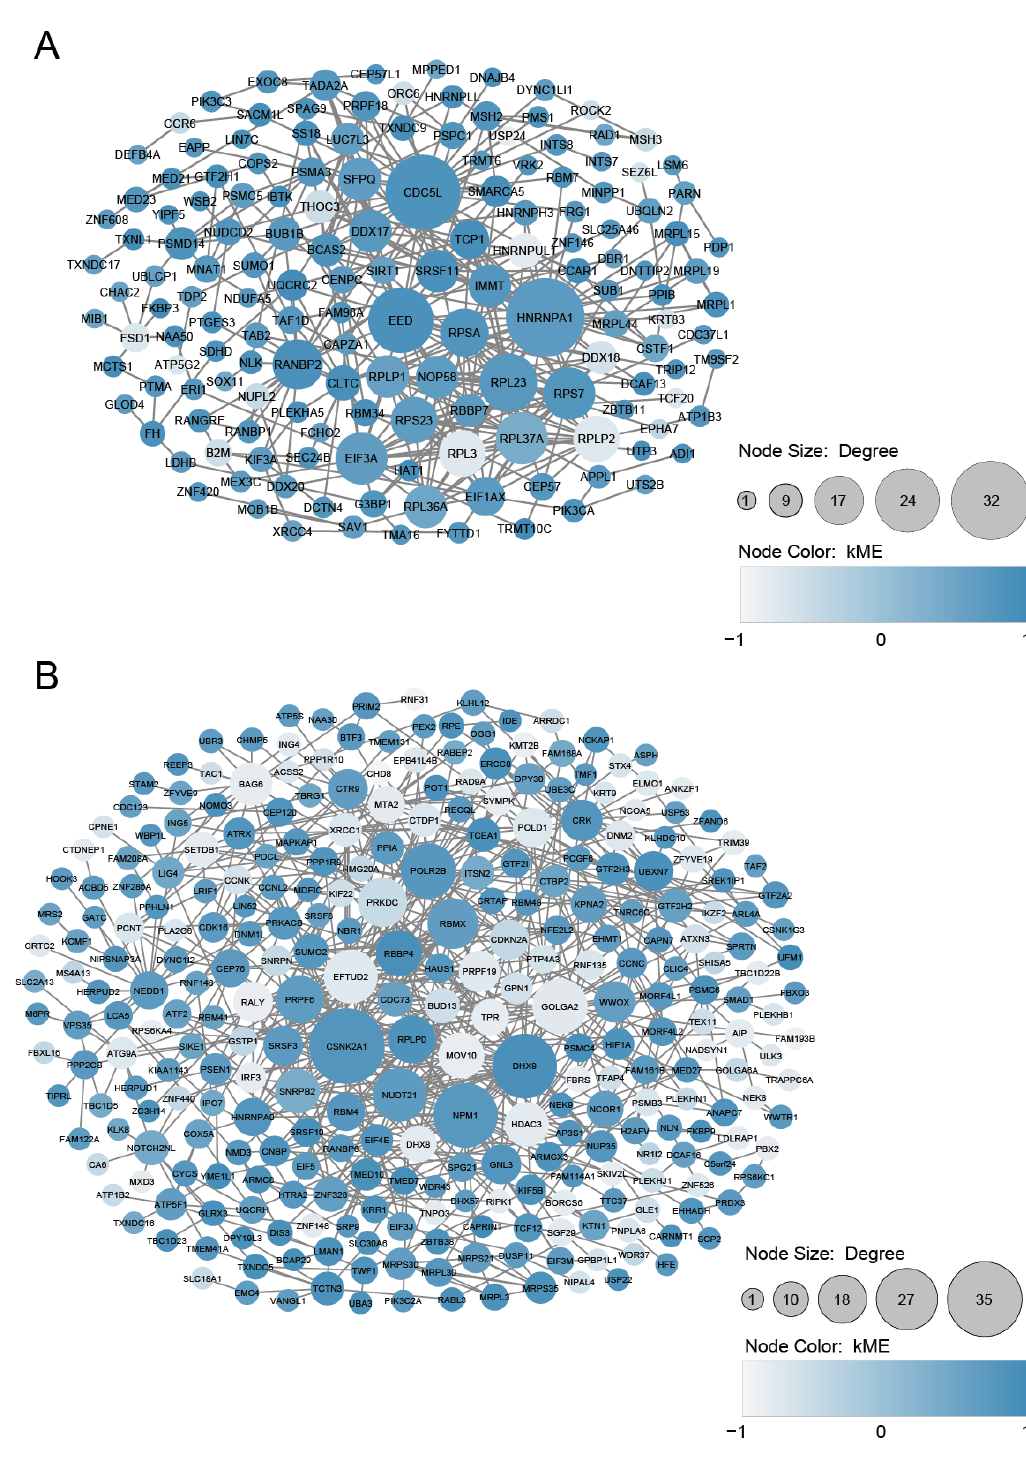
Figure 6. The preeclampsia (PE) protein – protein interaction (PPI) network constructed with the cyan ( A ) and magenta ( B ) module genes in the WGCNA. The genes of the cyan and magenta modules’ retrieved PPIs contained 158 and 298 nodes and 376 and 692 edges, respectively. The size of each node is proportional to its degree. The colors of the nodes (from lighter to darker) are proportional to their kME values.